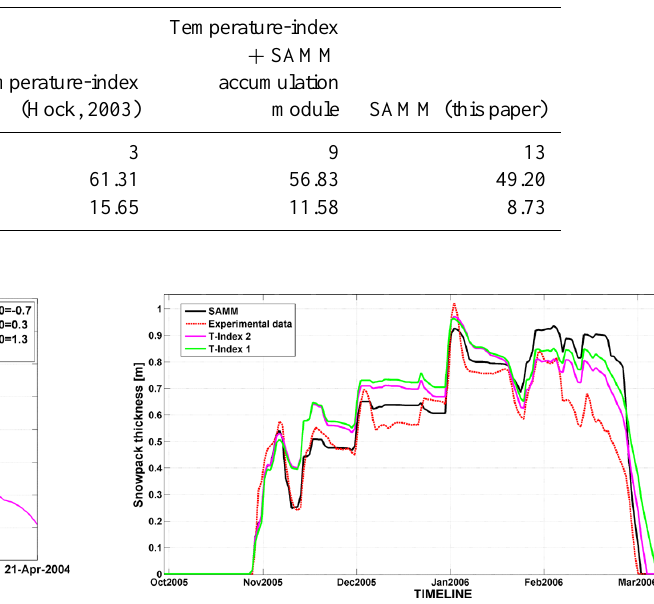
Fig. 7. Dynamic sensitivity analysis of the model for three different values of threshold temperature.